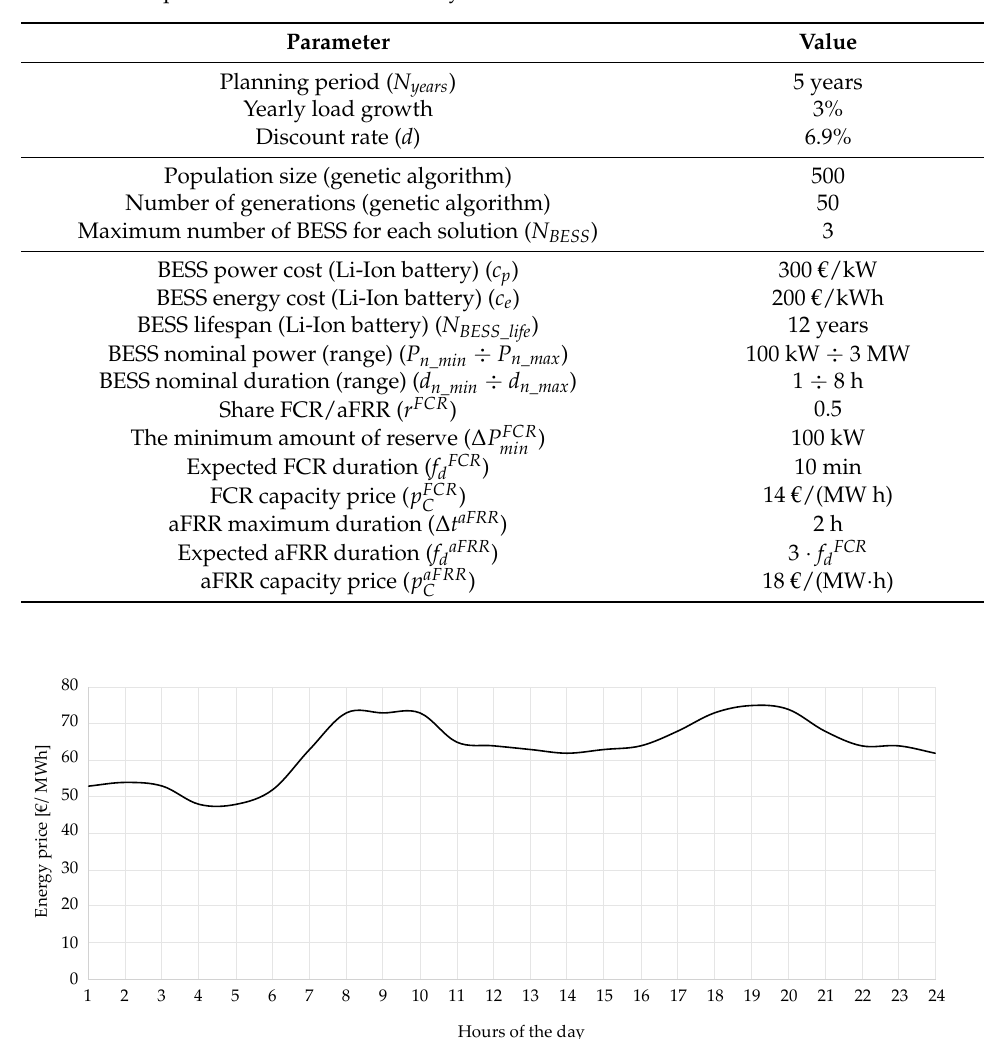
Table 1. Main parameters used for the study.